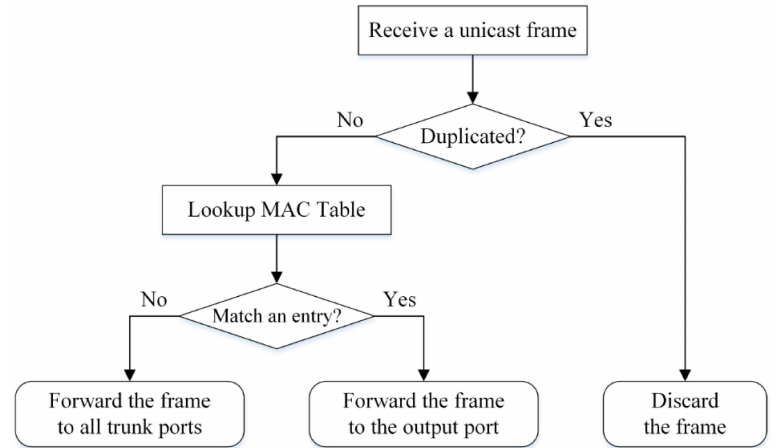
Figure 12. The process of forwarding unicast frames at SwitchBoxes.